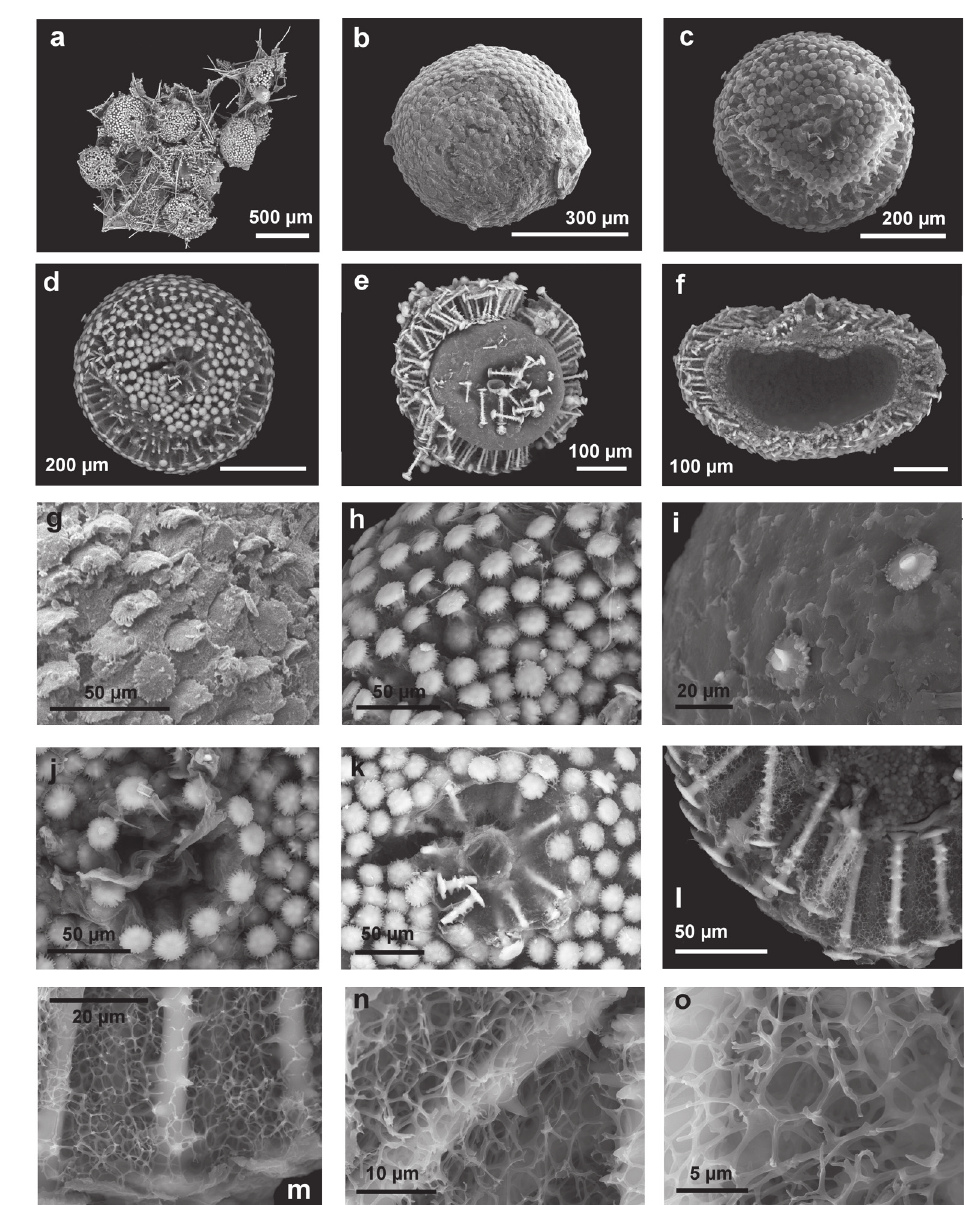
Fig. 4. Umborotula bogorensis (Weber, 1890) from the Sakaerat Biosphere Reserve, NE Thailand. SEM micrographs. a . Gemmules in a group within skeletal meshes. Gemmular theca with almost flat foraminal area. Several free gemmuloscleres also scattered in the skeletal network. b . Gemmule (basal area, top view) with developed outer layer covering the distal rotules of radial gemmuloscleres. c–d . Gemmules showing foraminal area (central); outer layer is lacking (top view). e . Gemmule without outer layer showing partially dissociated gemmuloscleres in the pneumatic layer and the smooth inner layer of compact spongin. Foramen simple, with short collar. f . Gemmule (cross section) with foraminal tubule and radial gemmuloscleres in the trilayered theca. g . Outer layer at the theca surface with distal rotules of gemmuloscleres. h . Distal rotules of gemmuloscleres without outer layer. i . Proximal rotules of gemmuloscleres adhering to the inner layer of the theca. j–k . Foraminal area supported by a network of spongin fibres and a rosette of radial gemmuloscleres. l . Architecture of trilayered gemmular theca with radial gemmuloscleres and spiny shafts (cross section). m–o . Fibrous network of thin spongin fibres in the pneumatic layer (detail, cross